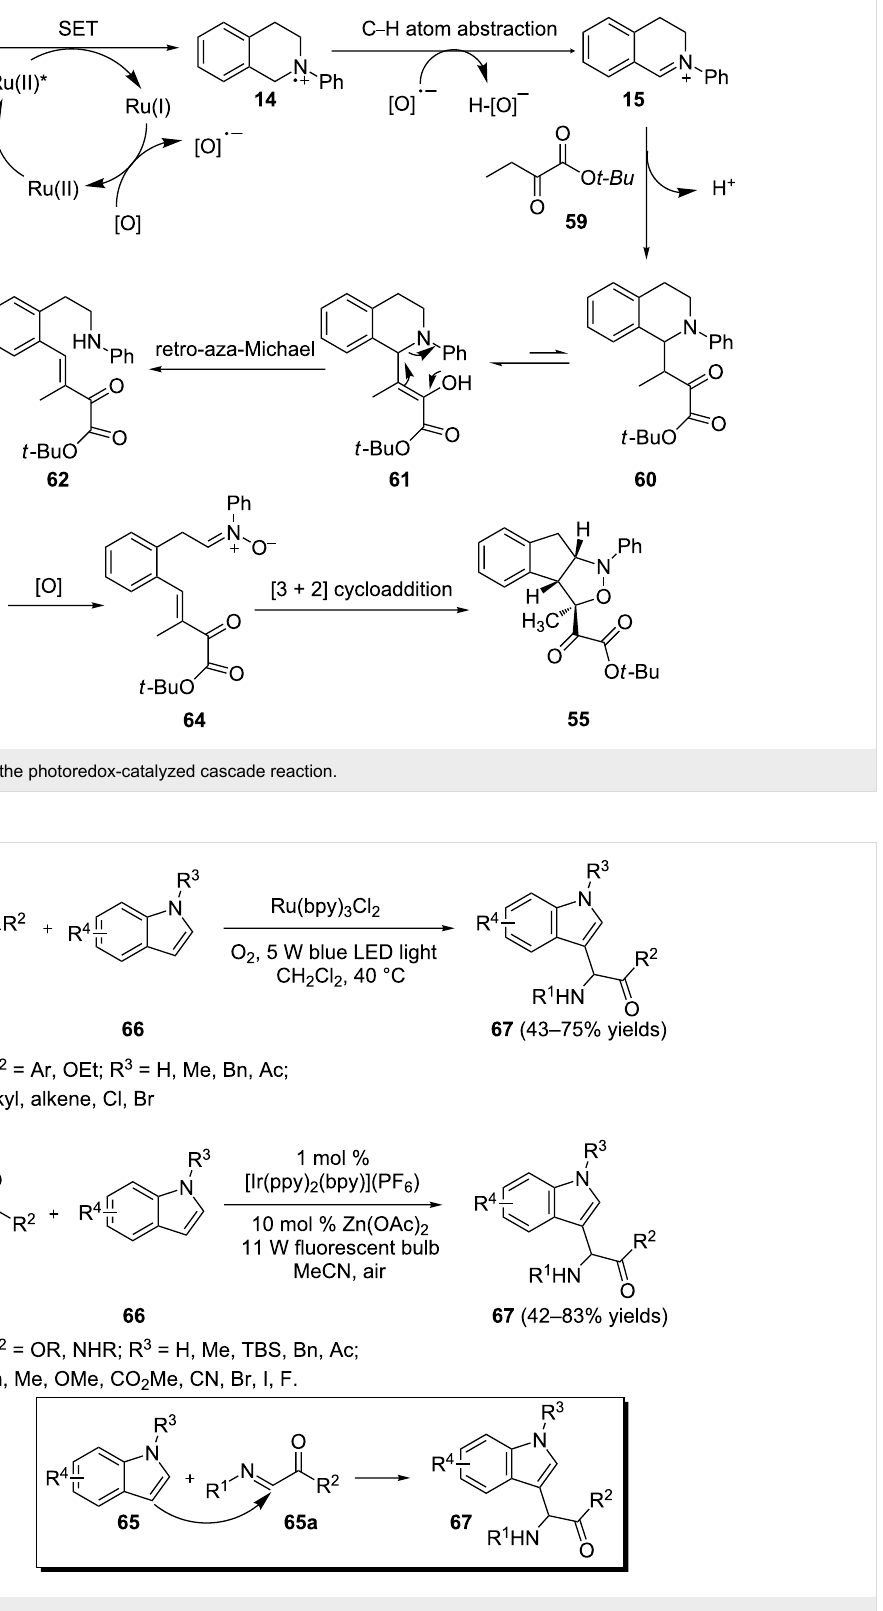
Scheme 16: Photoredox-catalyzed α -arylation of glycine